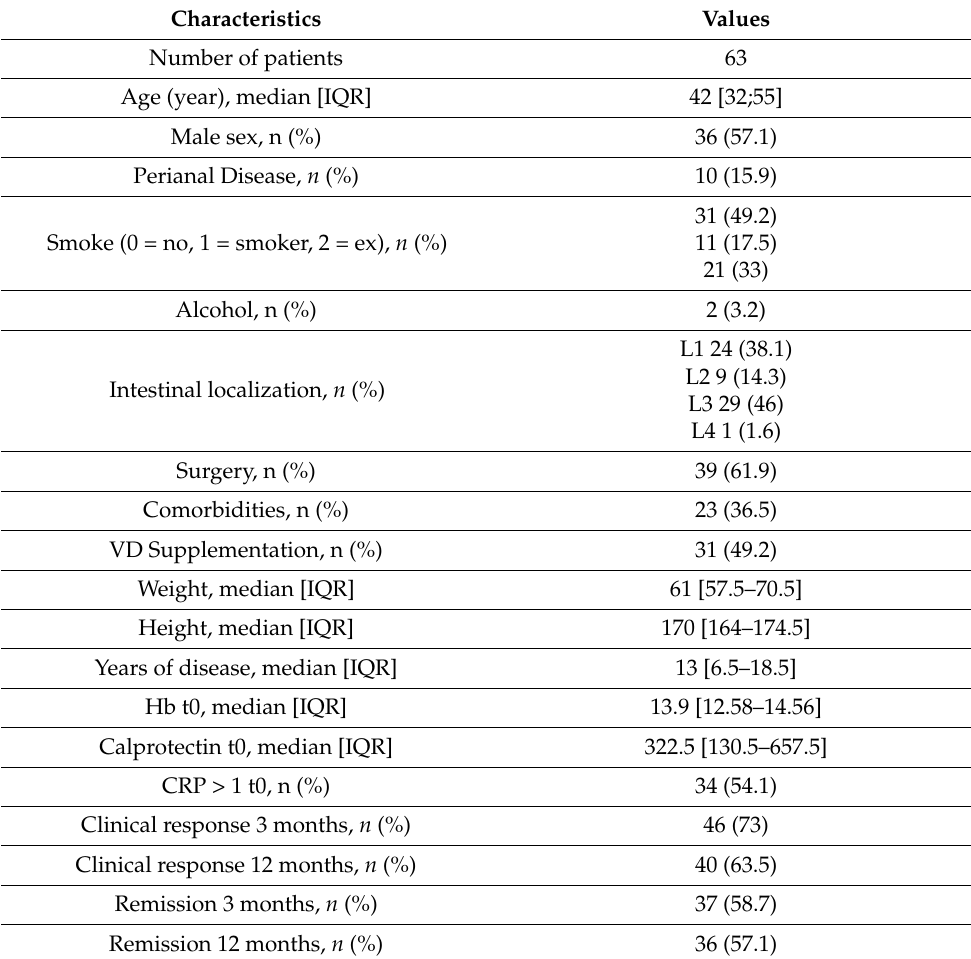
Table 1. Characteristics of patients. Categorical variables were described as numbers and frequencies, and linear ones as median and interquartile range